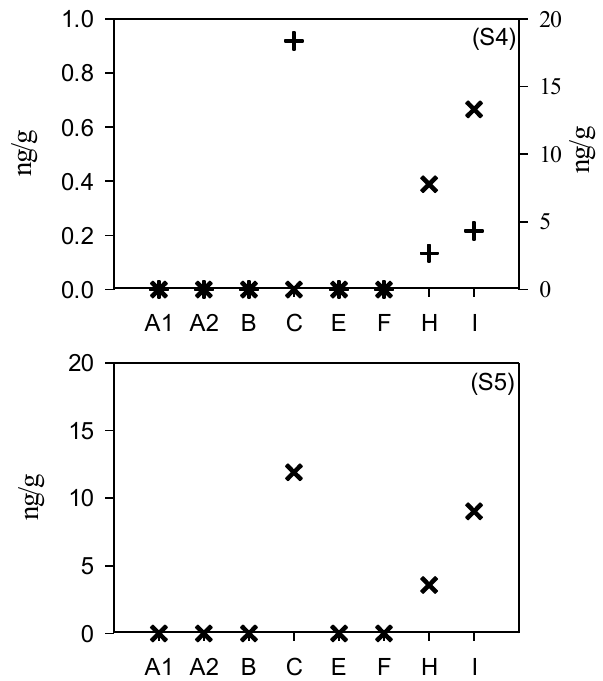
Fig. 3. Top: IP 25 concentrations in north Atlantic sediments (S4). Individual values within duplicates are represented by: left axis (X) and right axis ( + ) . Bottom: Concentrations of IP 25 in sediment from the Antarctic Peninsula (S5).